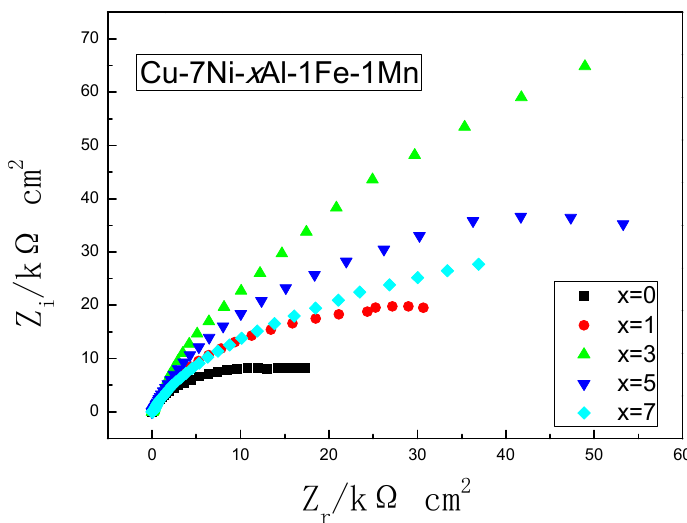
Figure 9 is the impedance response of the different alloys in the artificial seawater after 10 days.